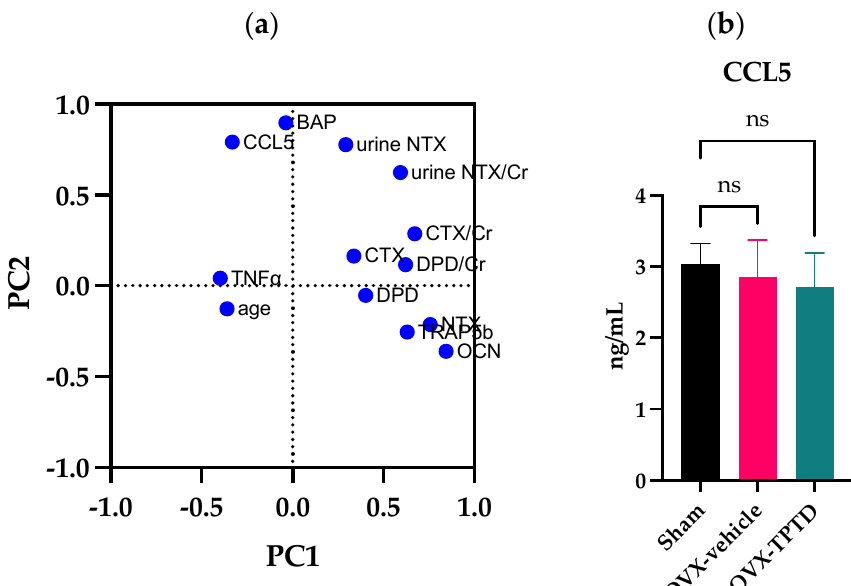
Figure 6. ( a ) A principal component analysis of all control and DJD-TMJ subjects and ( b ) the mea- surement of serum CCL5 levels in an ovariectomized (OVX) rat model. ( a ) The principal component analysis showed that CCL5, bone metabolism markers, and TNF- α were independent. ( b ) Serum CCL5 levels in sham-operated, OVX and OVX-TPTD-treated rats did not differ significantly. Dun- nett’s test.